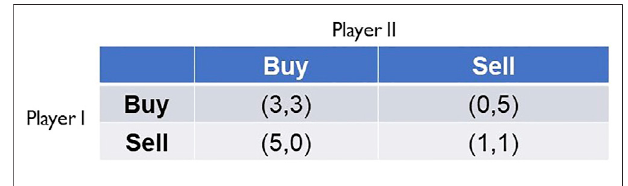
FIGURE 4 | High-frequency trading as an instance of Prisoners ’ Dilemma, as per the preferences described in expression